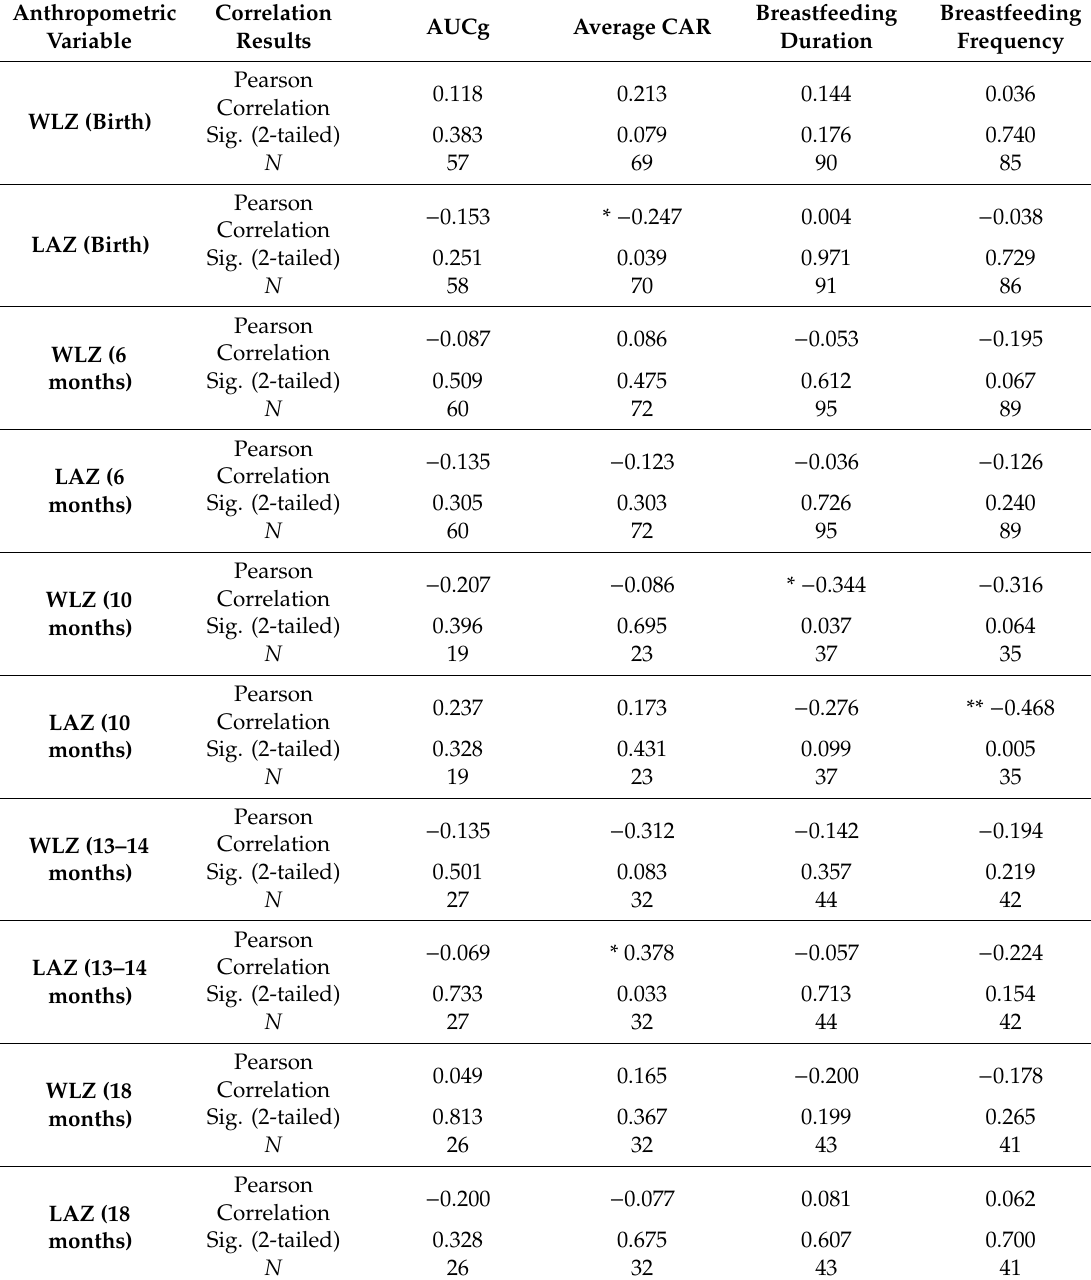
Table 2. Correlations among Maternal Prenatal Diurnal Cortisol Variables, Breastfeeding, and Infant Standardized Anthropometric Variables from Birth to 18 Months